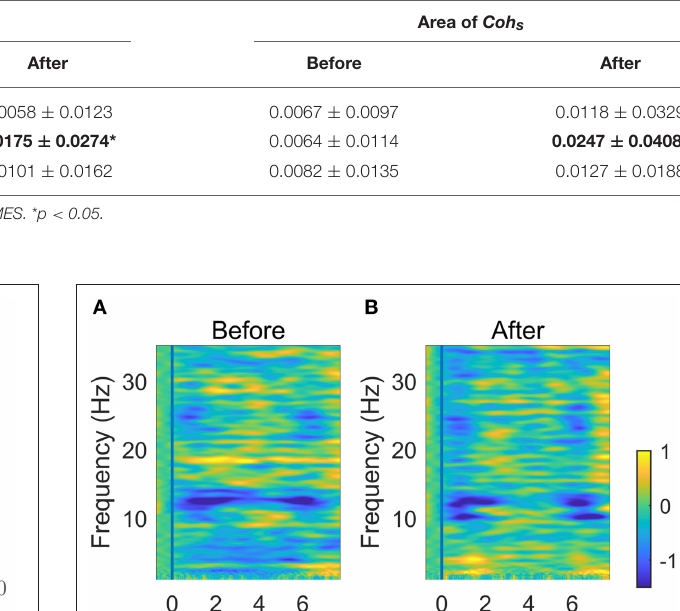
TABLE 2 | Maximal value and area of significant coherence.